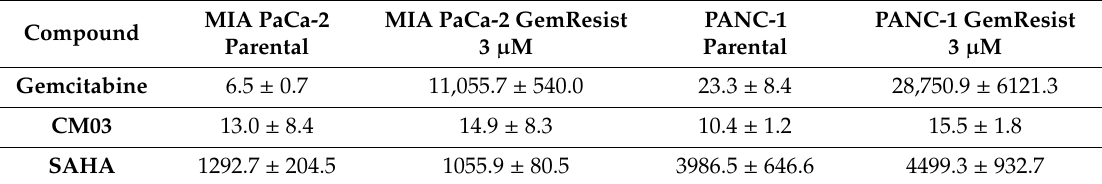
Table 1. GI 50 values (96 h sulforhodamine B (SRB) assay) for the drugs used in this study